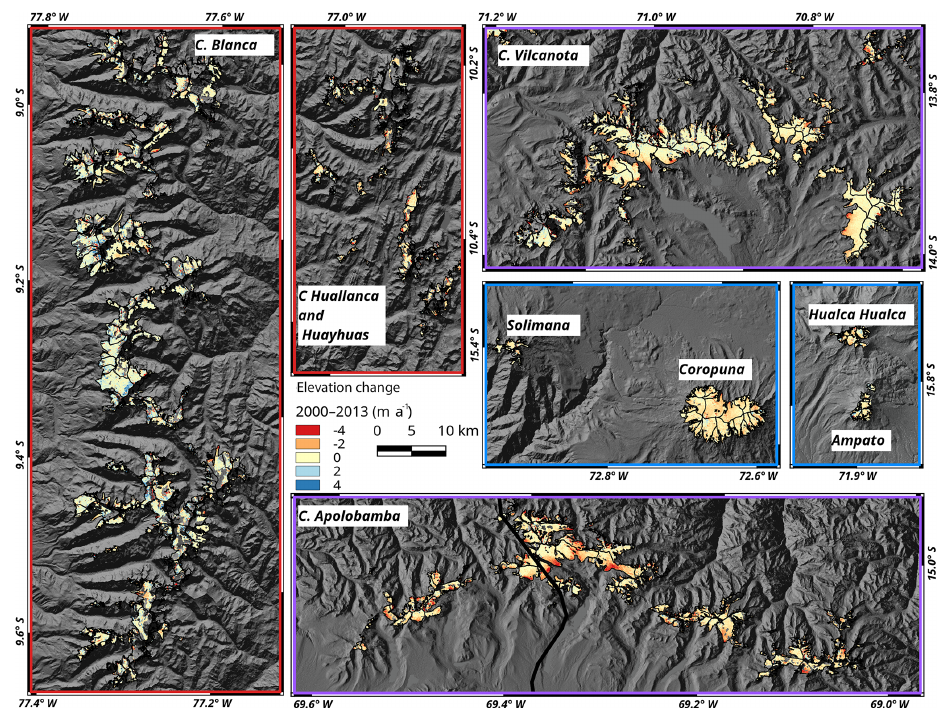
Figure 4. Surface elevation changes in the period 2000–2013 at mountain ranges in all three subregions (unfiltered). The frame colour of the panels indicates the subregions (see Fig. 1). Background: SRTM DEM hillshade ©